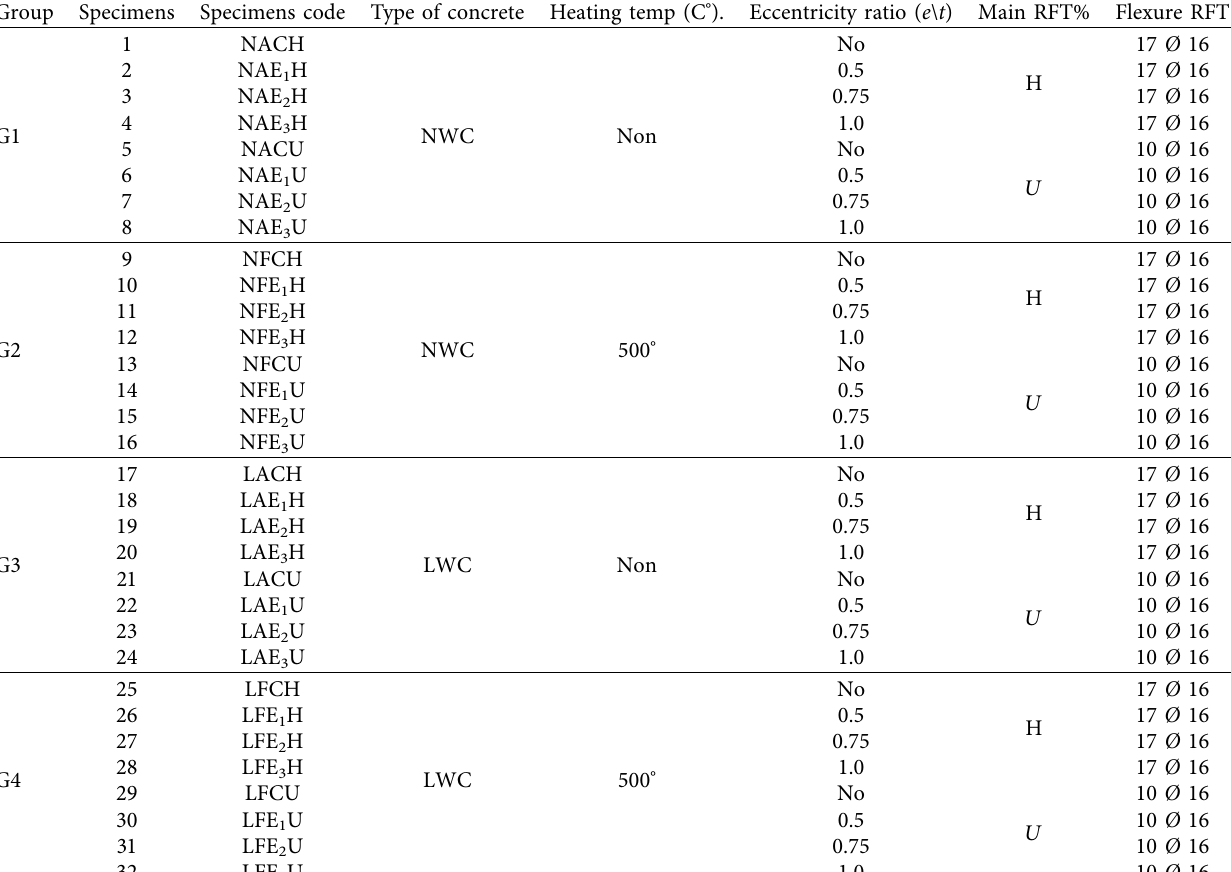
Table 4: Parametric study database of slabs.